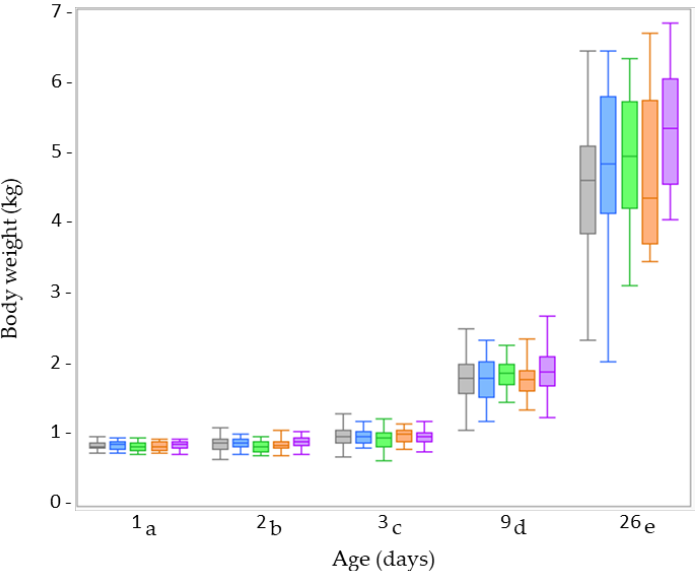
Figure 5. Boxplots of the body weight at different time points (day of birth [day 1], day 2, day 3, day 9, and day 26 [two days after weaning]) of low birth weight (LBW; n = 150) piglets per treatment (dense milk replacer [DMR] one dose [grey box], DMR three doses [blue box], no treatment [green box], sham one dose [orange box], sham three doses [purple box]) at Farm B. There was no effect of drenching DMR on body weight ( p = 0.345). Body weight increased during the experimental period independent of treatment and birth weight category ( p < 0.001). Ages carrying a different subscript letter were significantly different.